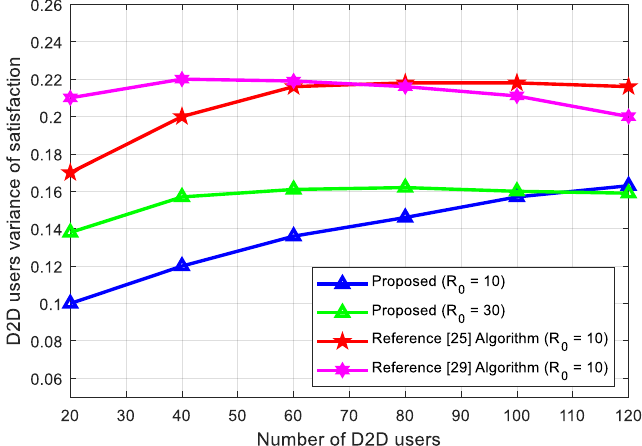
Figure 8. Comparison of the variance of satisfaction of D2D users under a different number of D2D users.